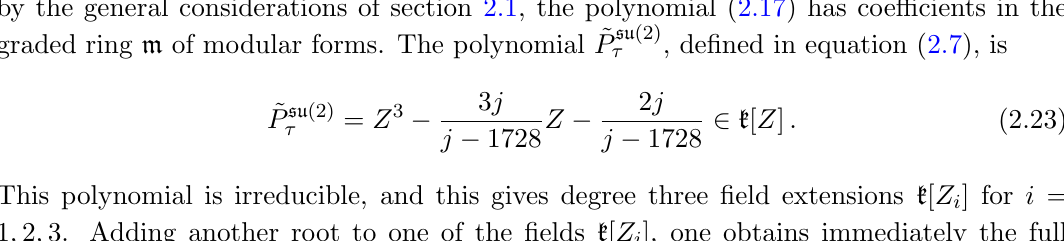
Figure 4 . Subgroup structure of S 3 . Each node is the subgroup that leaves invariant the corre- sponding (cid:12)eld in (cid:12)gure 5. The integer on each arrow indicates the ratio of the cardinalities of the two groups connected by the